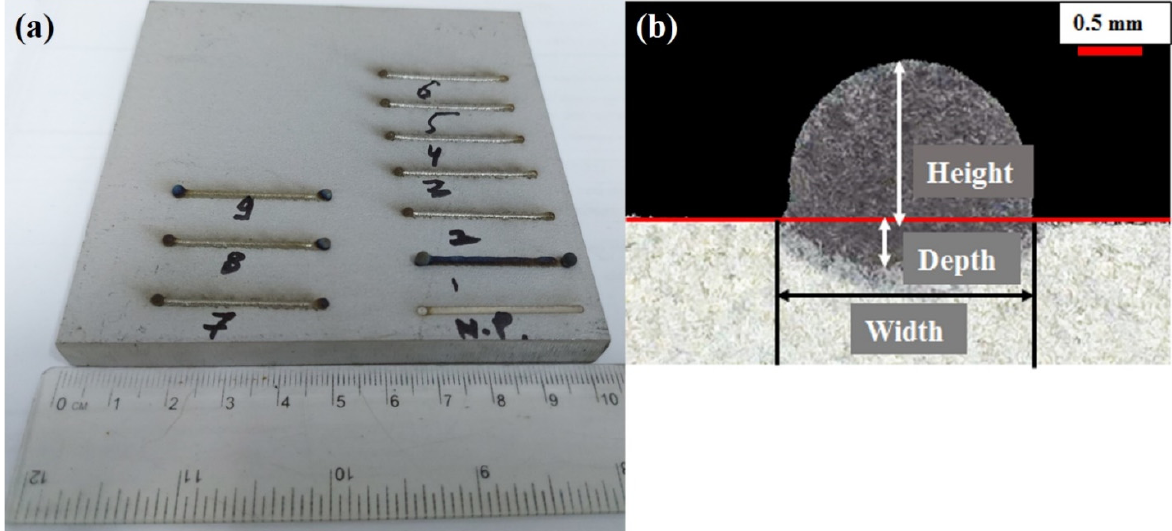
Figure 2. ( a ) Nine Ti6Al4V single tracks deposited on Ti6Al4V substrate and ( b ) a typical cross-section of an LMD deposited layer.